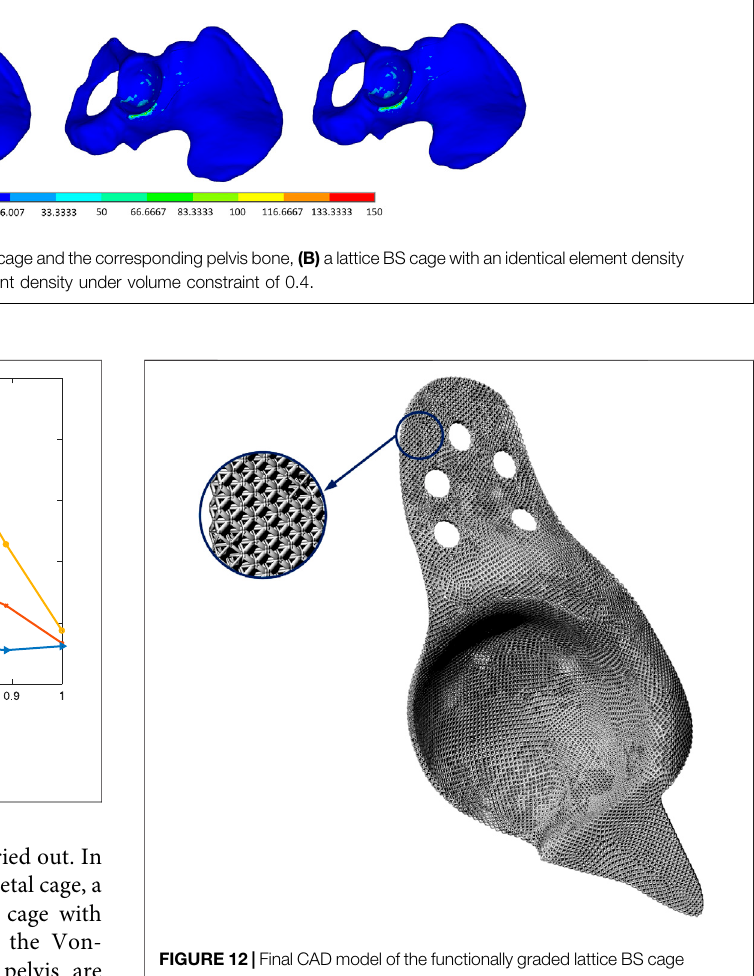
FIGURE 12 | Final CAD model of the functionally graded lattice BS cage and its partial enlarged